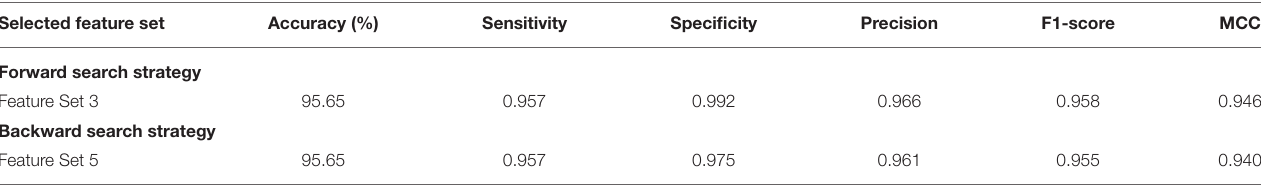
TABLE 4 | Testing performance metrics of the feature sets selected using forward and backward strategies. Selected feature set Accuracy (%) Sensitivity Specificity Precision F1-score MCC Forward search strategy Feature Set 3 95.65